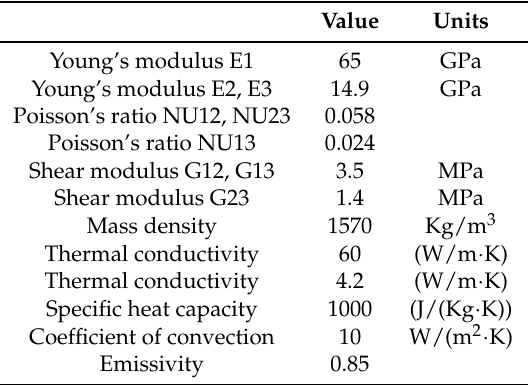
Table 1. Material properties used within the numerical model.